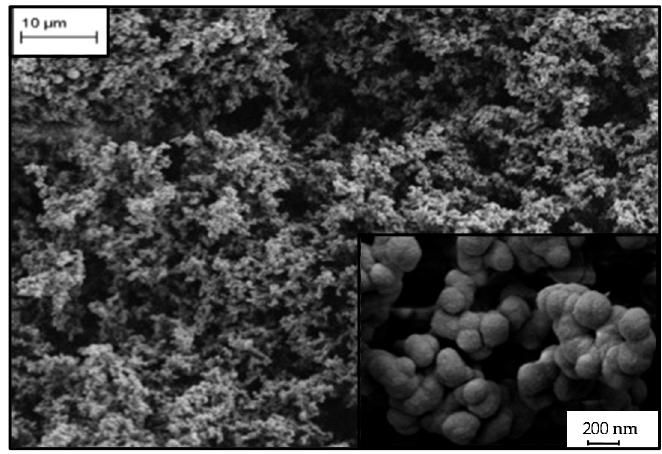
Figure 3. Microstructure of sf-RF aerogel with particles of about 0.12 µm and an average pore size of about 1.8 µm.